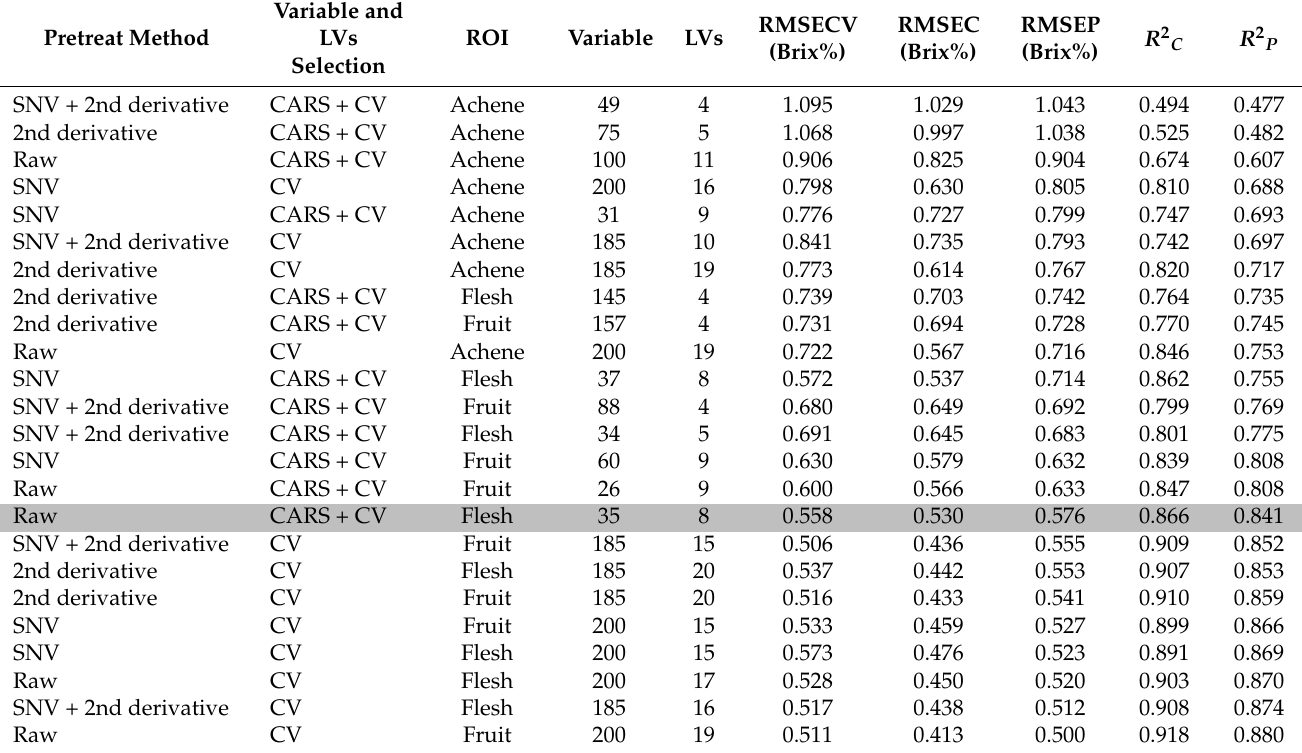
Table 1. Results of PLSR model search. The table is sorted in ascending R 2 p